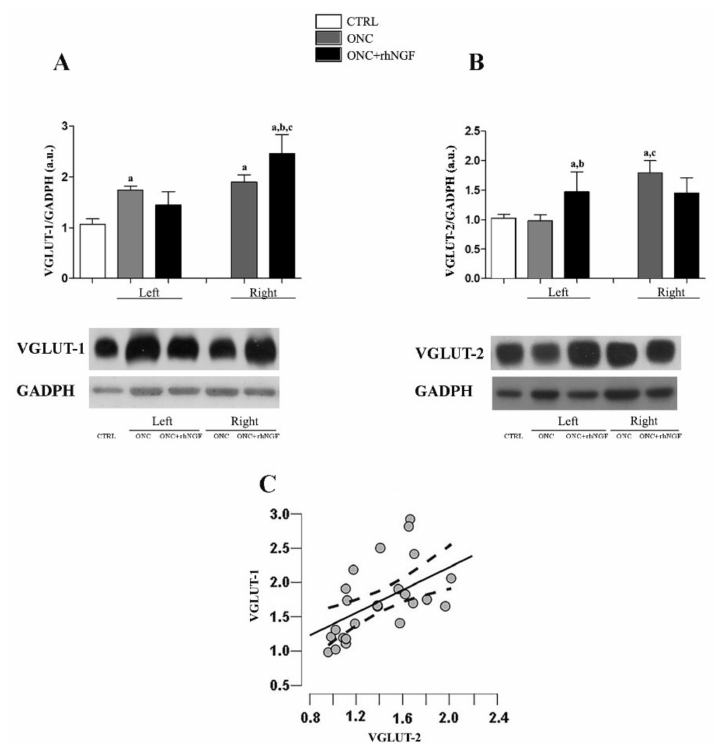
Figure 1. Western Blot of VGLUT-1 and VGLUT-2 level in visual cortex (VCx). ( A , B ) shows the semi-quantitative evaluation of levels of VGLUT-1 and VGLUT-2 in the left (ipsilateral) and right (contralateral) VCx of optic nerve crush (ONC) and ONC+rhNGF rats. No changes were detected by comparing the left and right VCx of CTRL rats. Data are expressed as mean optical density arbitrary units (a.u.) and presented as mean ± S.D. ( C ) show the Pearson’s correlation between the VGLUT-1 and VGLUT-2 in the VCx. Statistically different: a vs. CTRL; b vs. ONC; c left vs. right VCx (same treatment